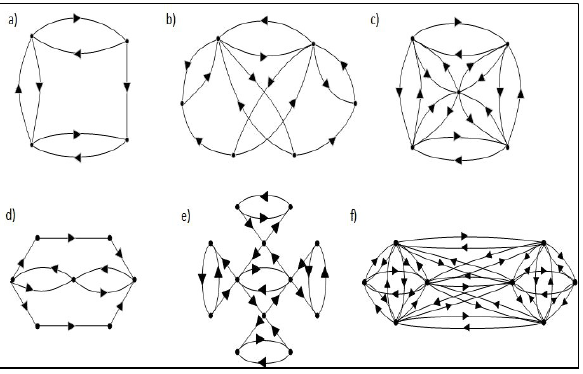
Figure 4. Examples of different network structures [1]